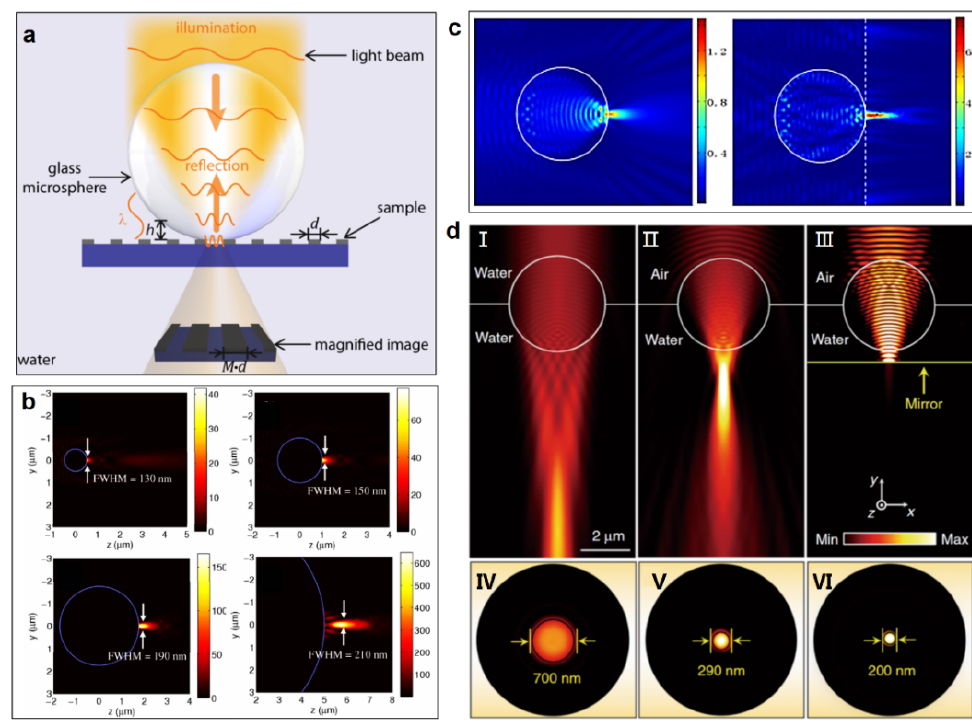
Figure 2. Principle of photonic nanojet generation. ( a ) Imaging schematic diagram of a grating sample using a microsphere superlens; ( b ) The near-field intensity and FWHM of the photonic nanojet generated by microspheres with diameters of 1.0 μ m, 2.0 μ m, 3.5 μ m, and 8.0 μ m; ( c ) Theoretical simulation of the light field distribution of microspheres on air and a Si substrate; ( d ) Optical intensity distributions of light focusing and light spots by a microlens fully immersed in water, semi-immersed in water, and suspended on the surface of a mirror.